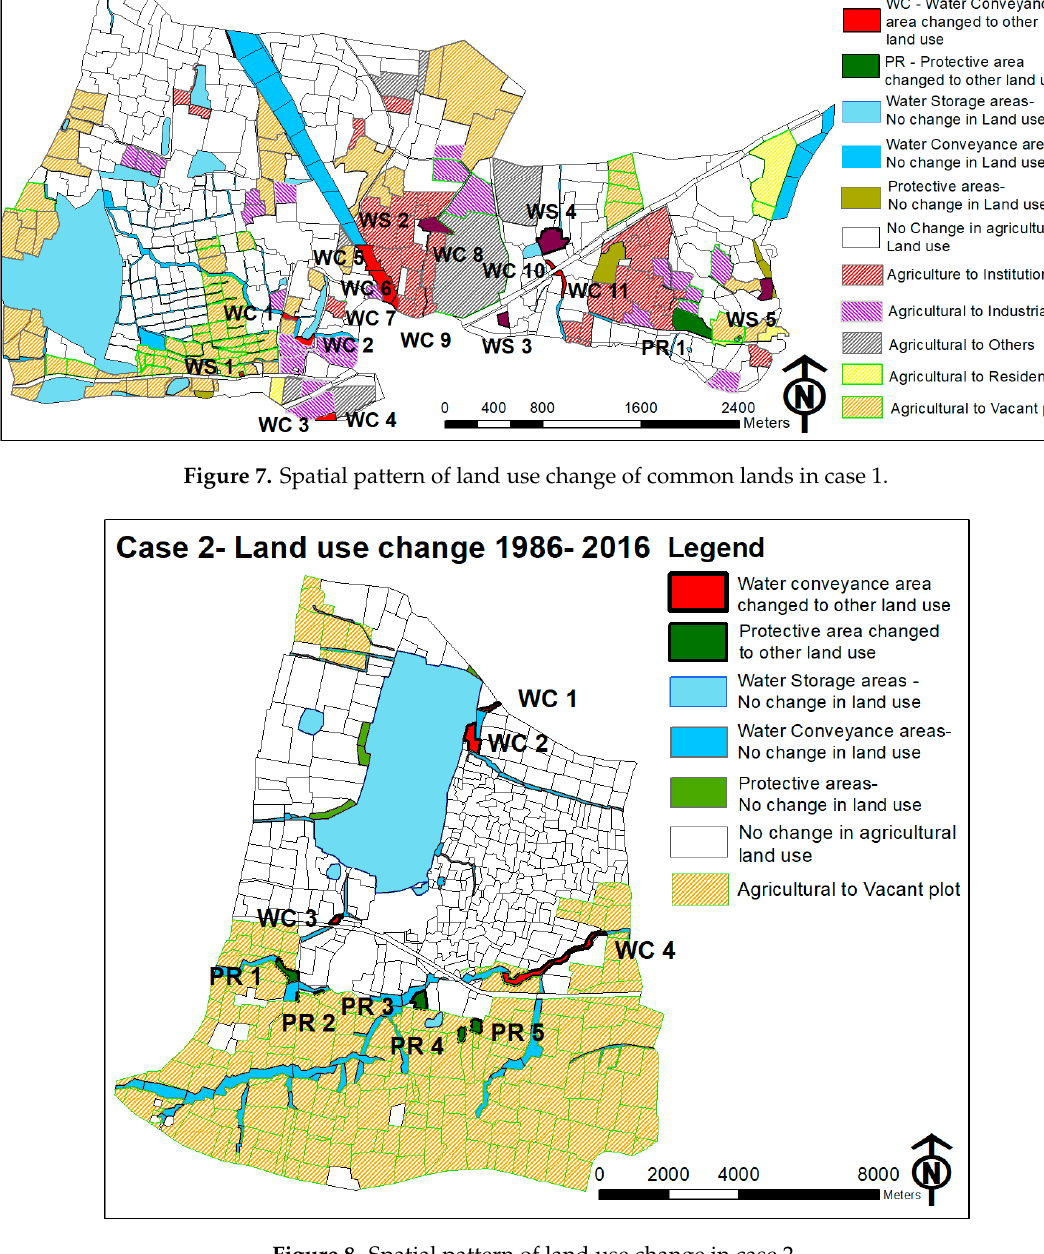
Figure 8. Spatial pattern of land use change in case 2.